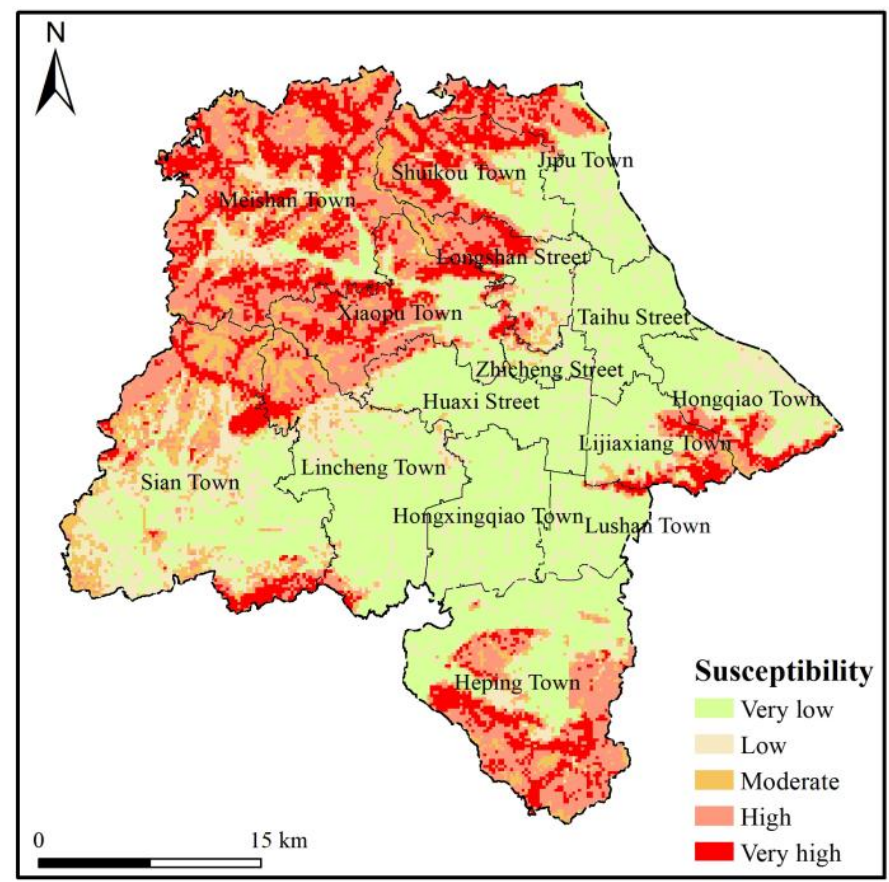
Figure 5. Global susceptibility evaluation zone map.